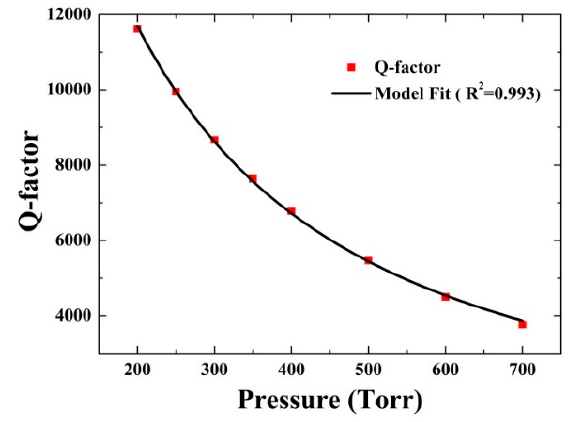
Figure 4. Q -factor of the QTF as a function of the gas pressures.